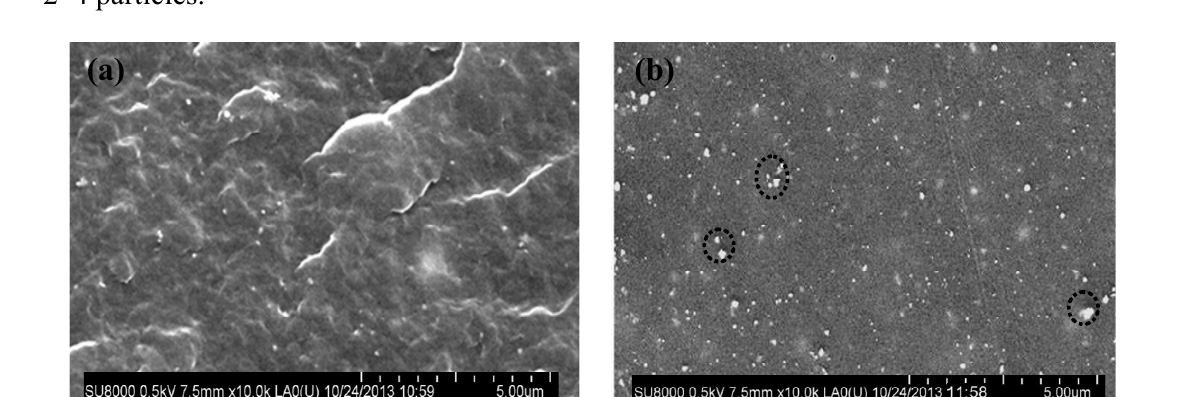
Figure 1. Typical SEM micrographs of PHB/ZnO nanocomposites with ( a ) 1.0 wt % and ( b ) 10.0 wt % nanoparticle content. The dashed circles on Figure 1b show small clusters of 2–4